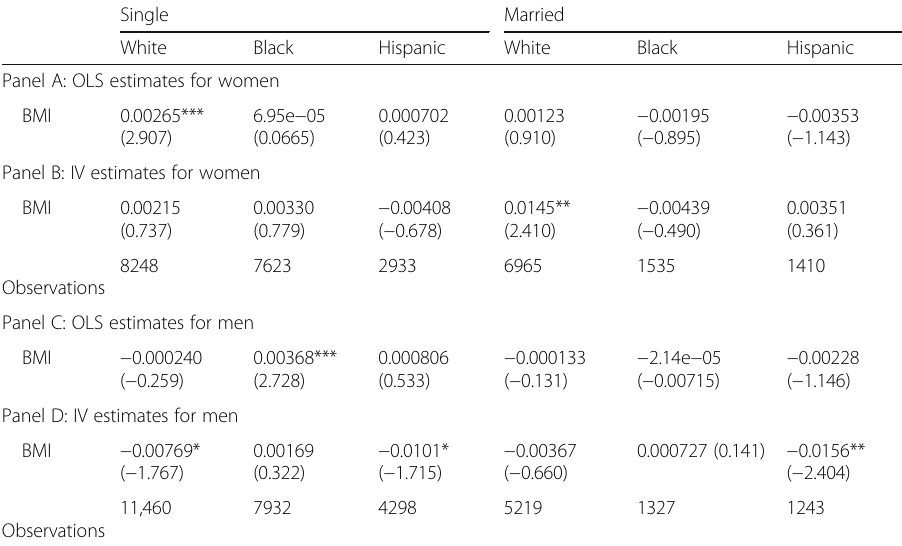
Table 13 Effect of weight on employment probability: OLS and IV results for men and women with sibling Single Married White Black Hispanic White Black Panel A: OLS estimates for women